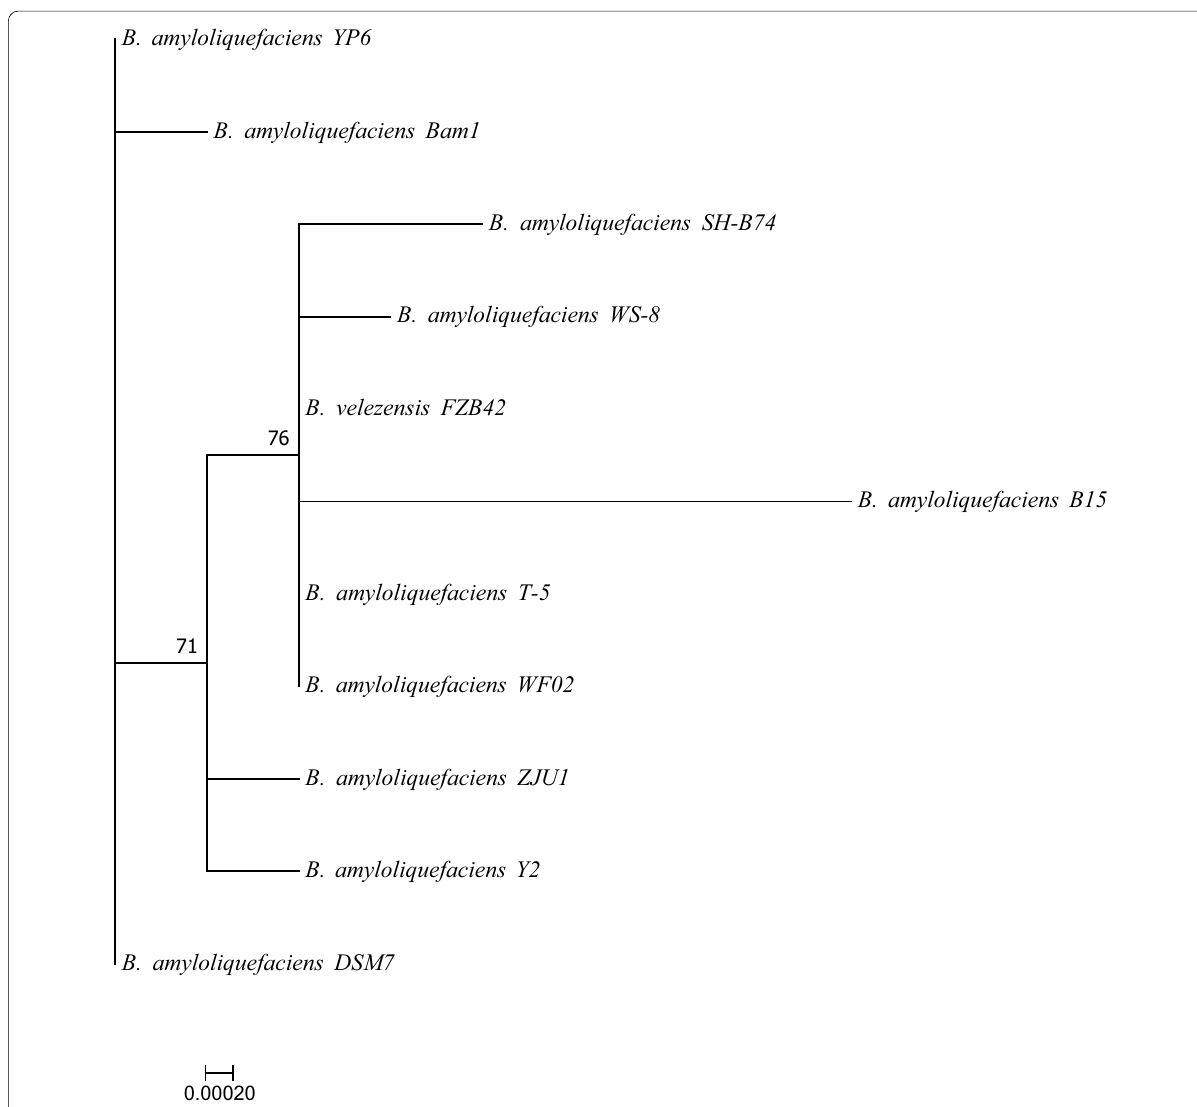
Fig. 3 Phylogenetic tree for B. amyloliquefaciens strain Bam1, B. velezensis FZB42, and the nine other B. amyloliquefaciens strains based on homologous